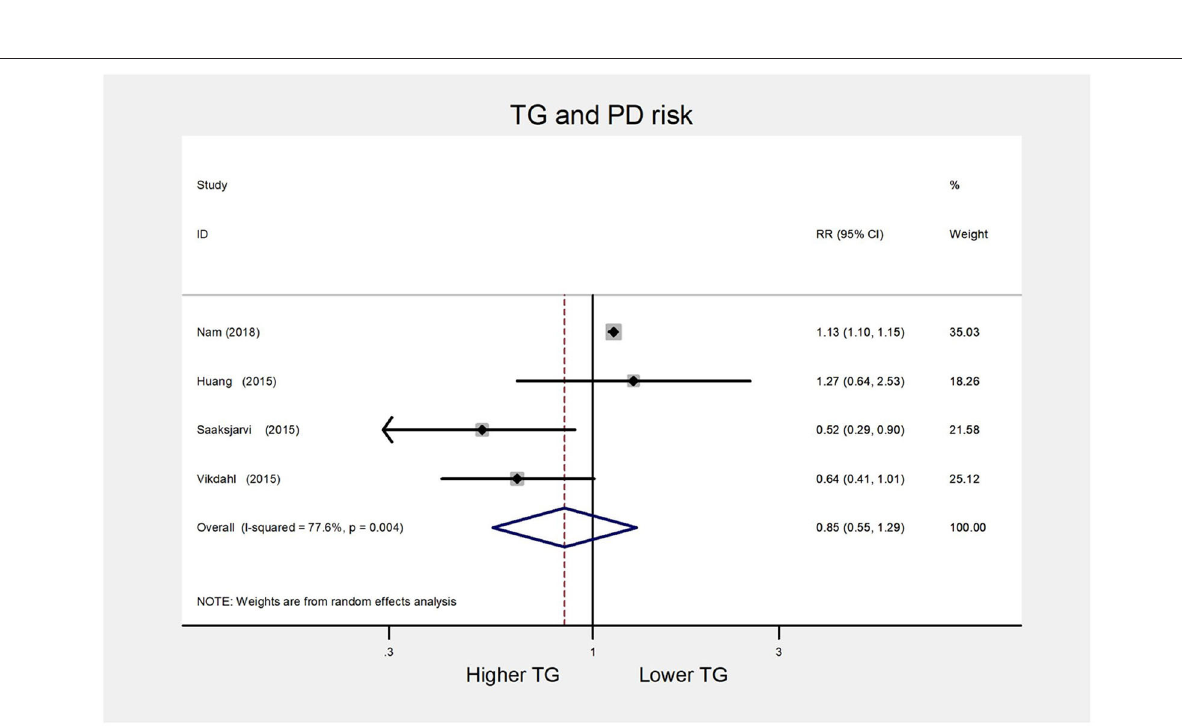
Frontiers in Neurology | www.frontiersin.org